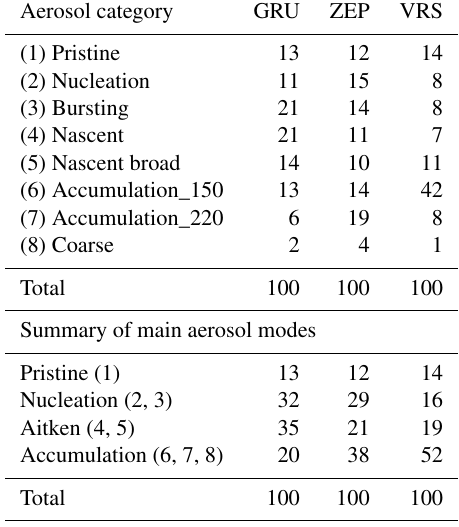
Table 1. Occurrence of the k -means cluster analysis featuring the eight aerosol categories detected at the three monitoring sites. At the bottom of the table general aerosol size distribution modes rep- resenting the sum of selected aerosol categories are